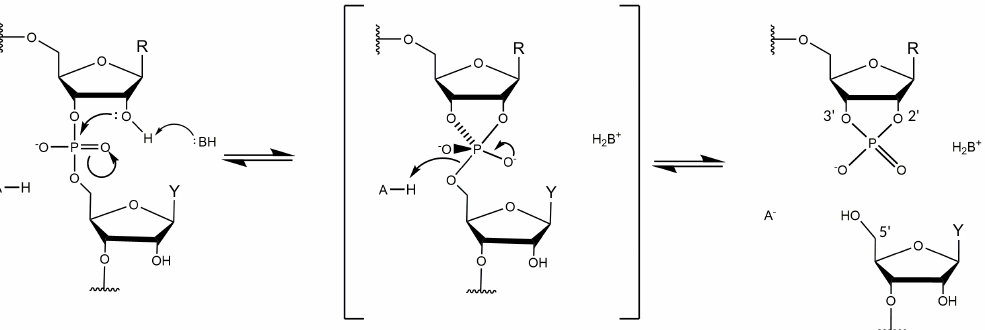
Figure 2. Proposed reaction mechanism of the 10-23 DNAzyme. A proton is abstracted from the 2’-hydroxyl group on the ribose of the unpaired purine nucleotide by an unknown Brønsted base B. The resulting oxyanion functions as a nucleophile that attacks the phosphorus center of the phosphodiesterbond, thus generating a penta-coordinated phosphorane intermediate. The intermediate degrades into two RNA fragments: one fragment that terminates in a 2’-3’-cyclic phosphate and a second fragment that terminates in a 5’-hydroxyl group. R = purine at substrate position 0; Y = pyrimidine at substrate position +1 (Figure 1A). Based on Reference